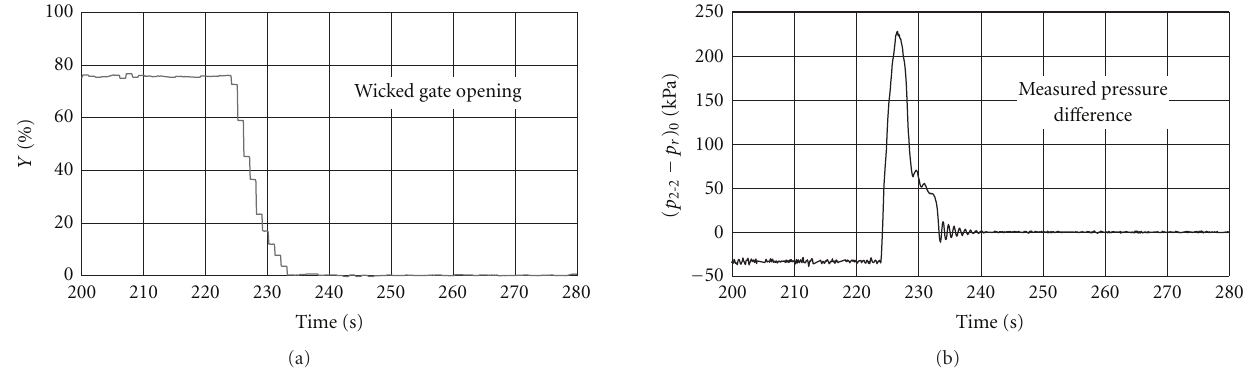
Figure 4: Guide vane closure percentage and change in pressure between section 2-2 depending on time t